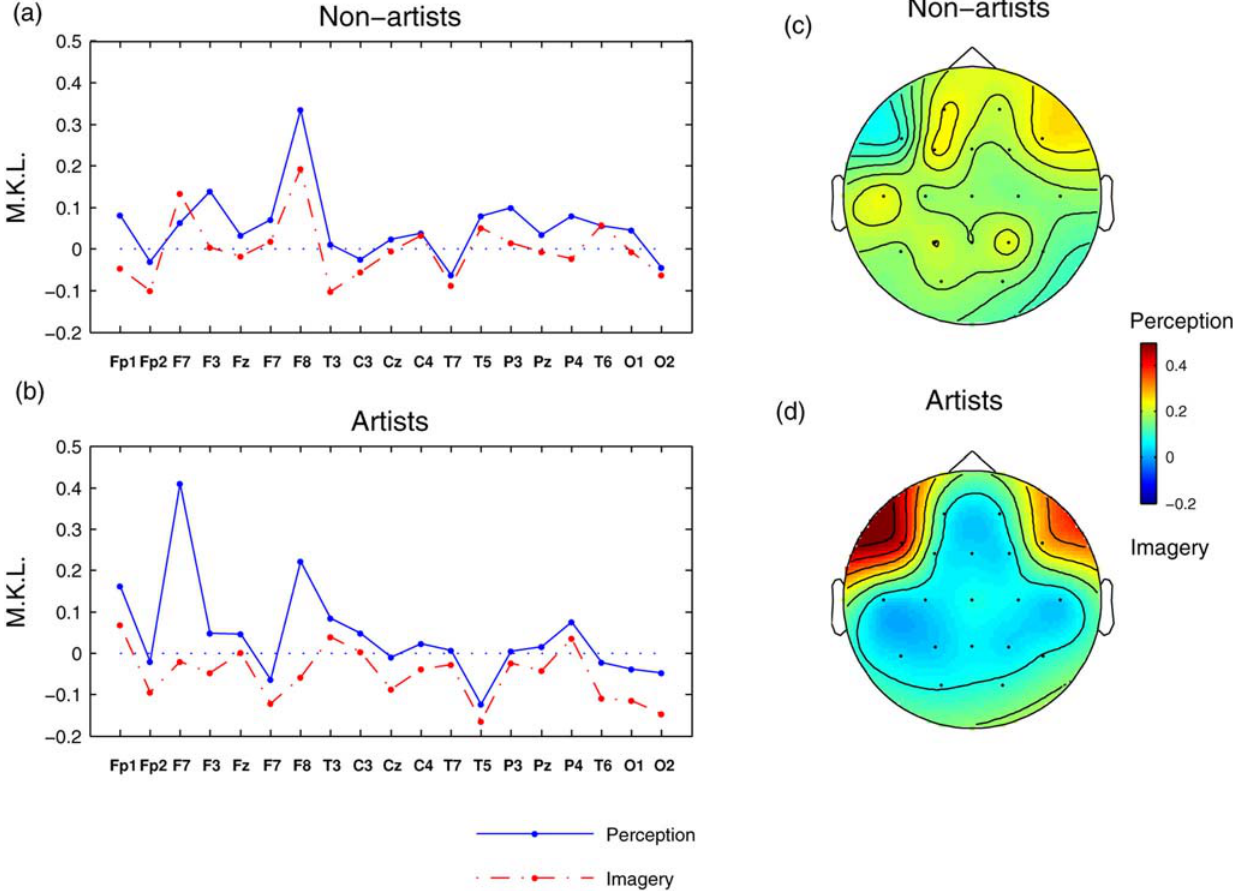
Figure 4. Universality in theta band for artists and non-artists. MKL divergence measure in theta band oscillations for (a) non-artists and (b) artists, respectively. The results were averaged across participants within group, electrode pairs. Note the overall decrease of divergence, i.e. increase of universality for mental imagery condition as compared to visual perception condition. (c–d) Topographical profiles for (a–b). Strongest divergence was observed in frontal regions in both hemispheres for the